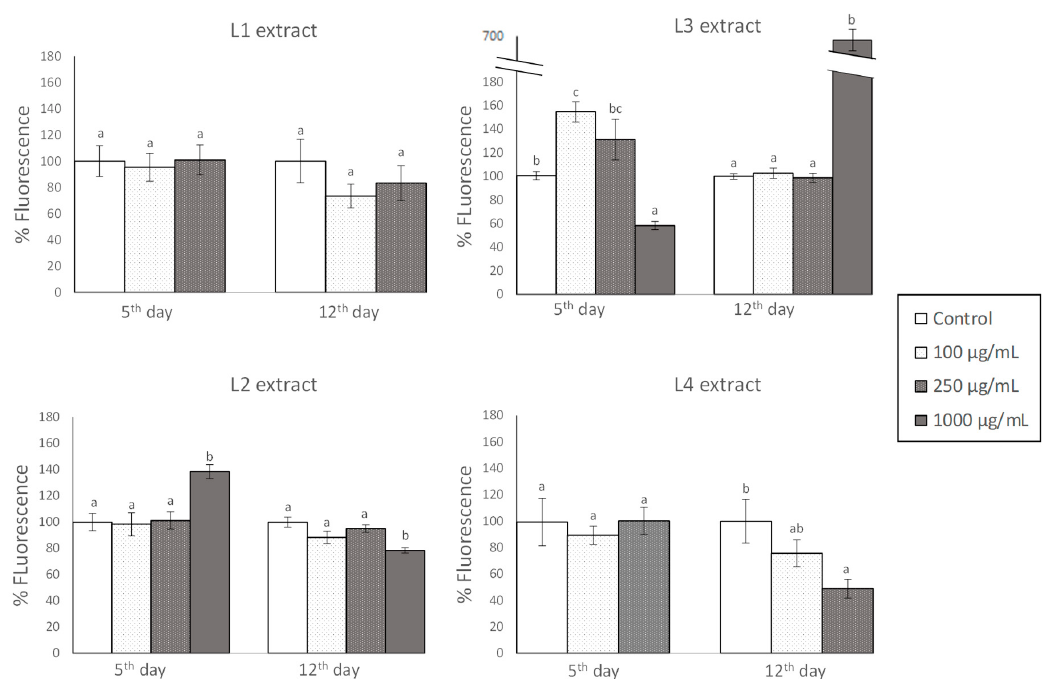
Figure 3. Accumulation of reactive oxygen species (ROS) determined at the 5th day (left side) and the 12th day (right side) of adulthood in worms grown in the presence of different concentrations of the pomace extracts and exposed to thermal stress (2 h at 35 °C). Results are expressed as percentage of fluorescence in relation to control worms that were not treated with grape pomace extracts. The results are presented as the mean values ± SEM ( n = 3). Statistical significance was calculated using by one-way analysis of variance ANOVA. Different letters in bars indicate significant differences ( p < 0.05).